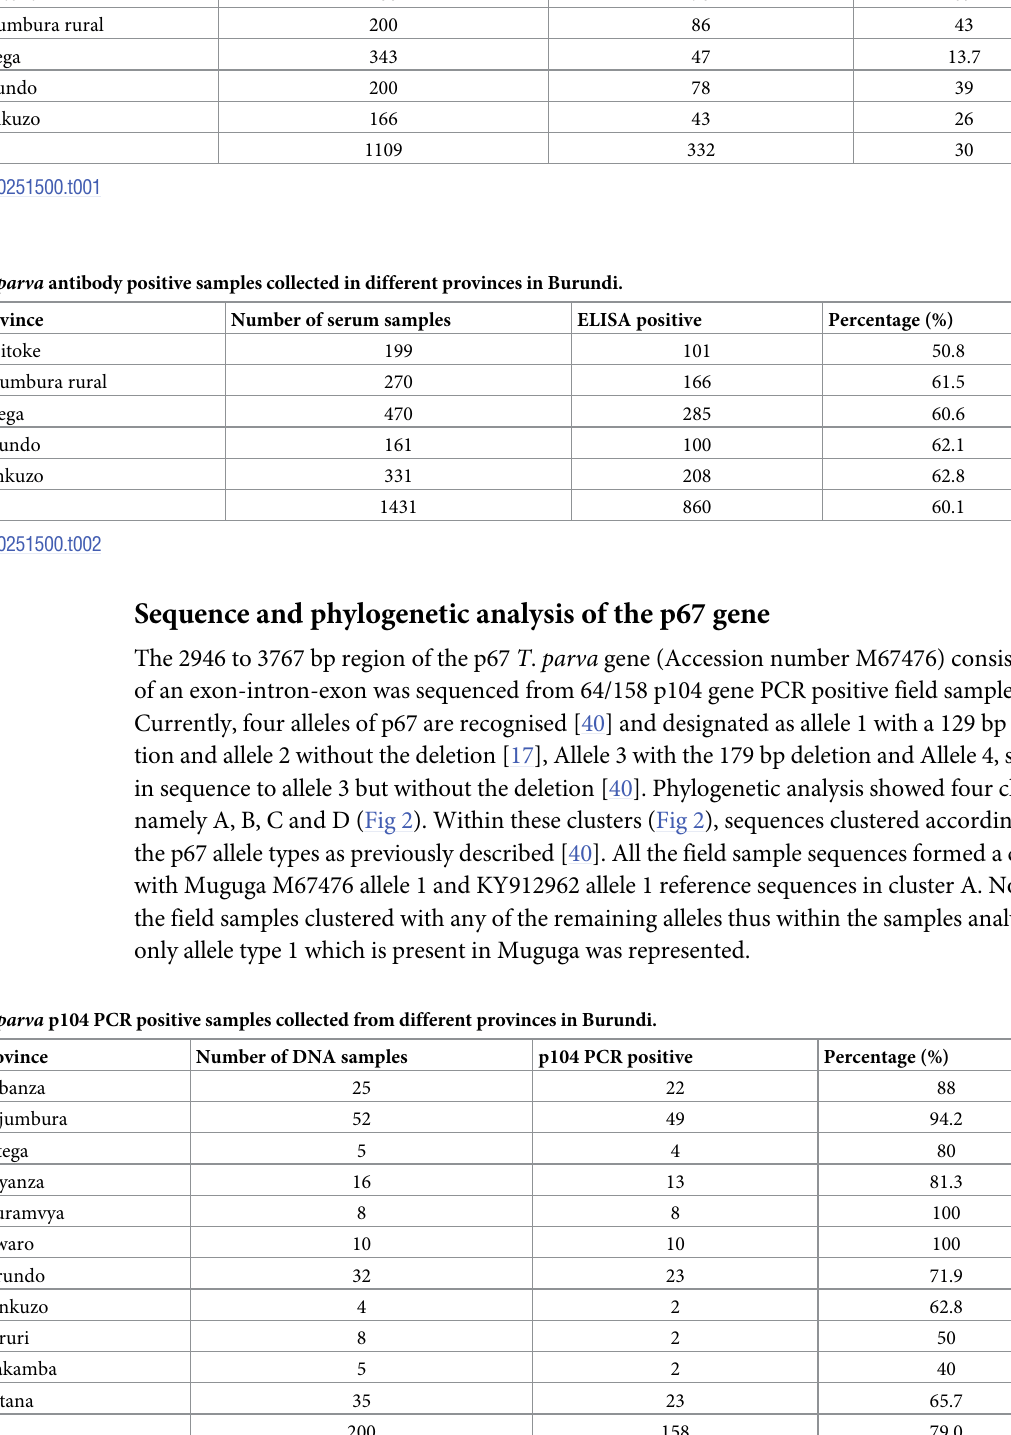
Table 1. Proportion of Theileria species-like blood smear positive samples collected from the different sites in Burundi. Region